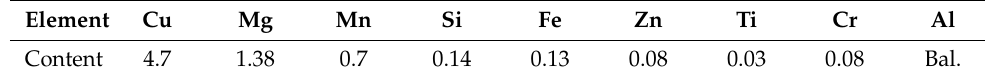
Table 1. Chemical composition of 2024 aluminum alloy (wt %).